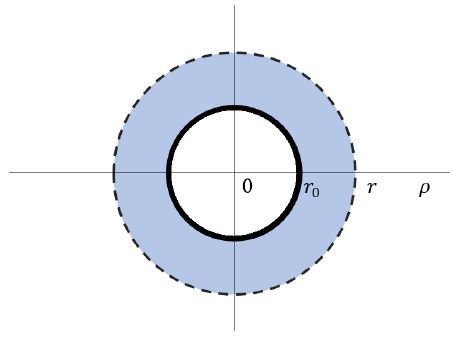
Figure 1: The cylindrical anisotropic waveguide (cid:6)